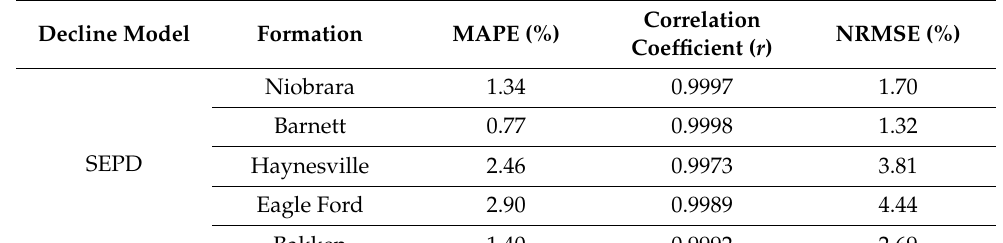
Figure 4. Example of production history matching of entire production history data with the Arps hyperbolic decline model for a well in the Niobrara formation. Table 4. Error analysis results for production history matching using entire production history with the stretched exponential production decline (SEPD) model.